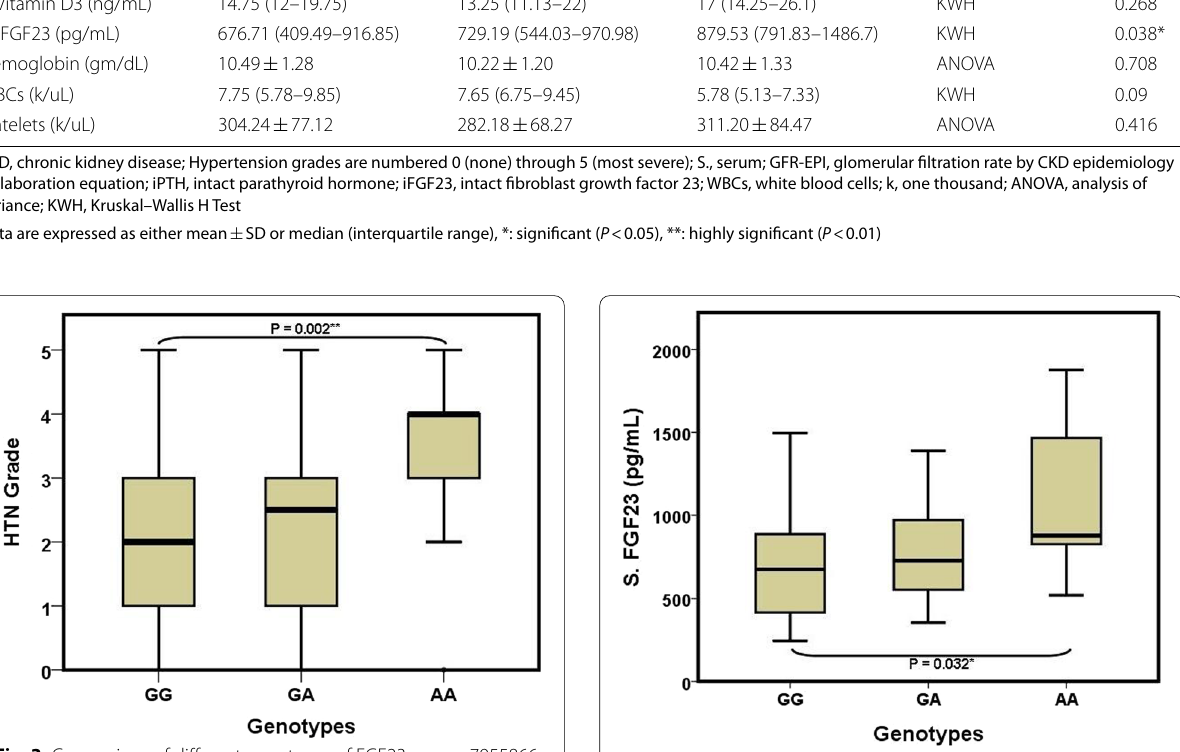
Fig. 4 Comparison of different genotypes of FGF23 gene rs7955866 SNP in CKD patients according to serum iFGF23, showing the P value for the difference between GG and AA phenotypes in post hoc pairwise